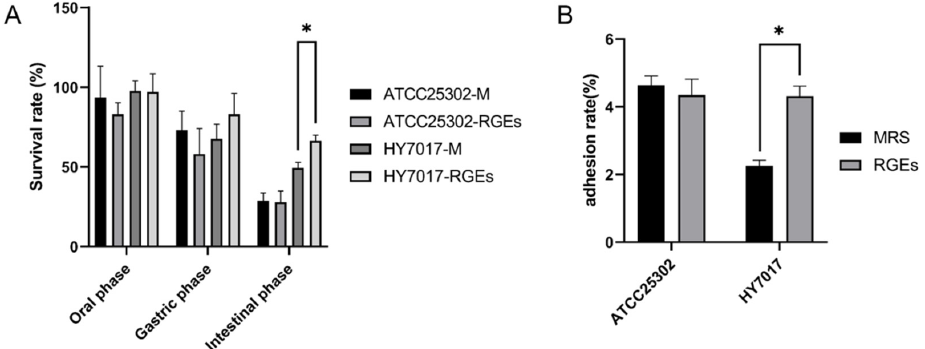
Figure 5. The survival rate of HY7017 and ATCC25302 during simulated gastrointestinal tract ( A ). The number of LAB attached to one Caco-2 cell under co-culture conditions ( B ). Data are represented as the mean ± standard error of the mean (SEM) of three independent experiments (* p < 0.05).